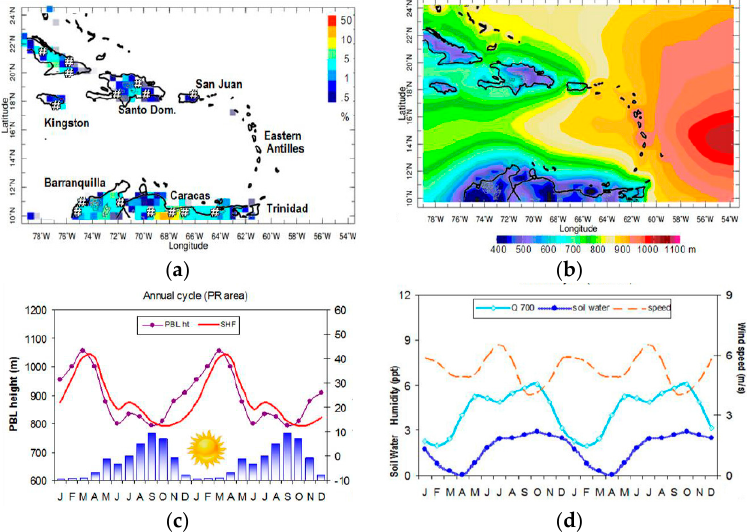
Figure 1. ( a ) Caribbean region Global Fire Emissions Database (GFED) fire density (shaded) and cities >500 K hash-mark, ( b ) 2005–2015 average MERRA2 planetary boundary layer (PBL) height (m). Mean annual cycle ×2 of ( c ) PBL, sensible heat flux (SHF), rain (bars up to 5 mm/day), and ( d ) 700 hPa specific humidity, soil water (cm) and surface wind speed. Sun icon in ( c ) represents dry season.